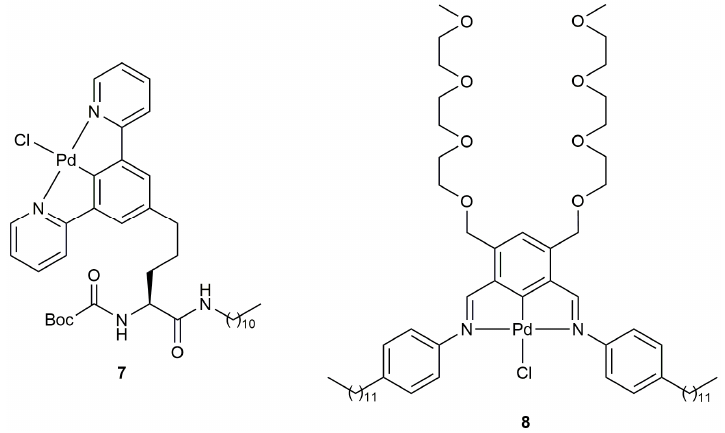
Figure 1. Structure of the pincer palladium(II) complexes 7 and 8 .